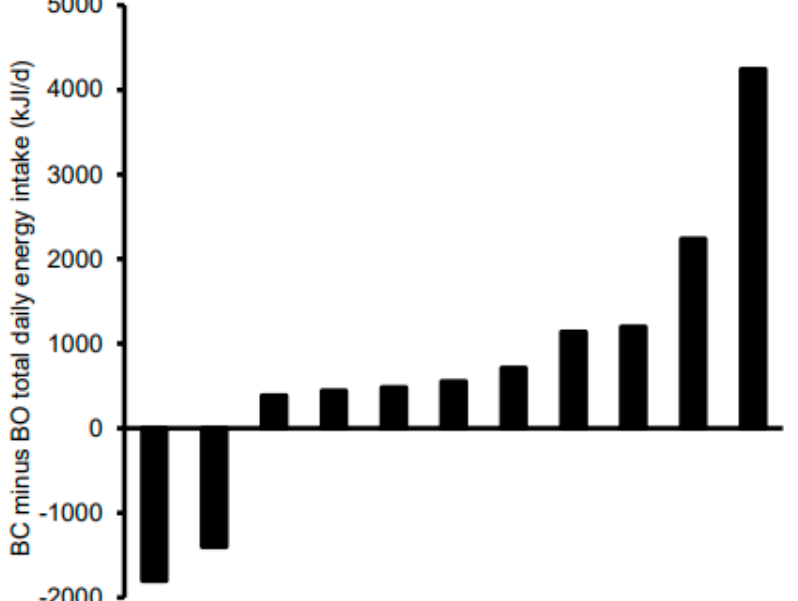
Figure 3. Individual total daily energy intakes of adolescent girls who participated in the randomised crossover trial comparing seven days of breakfast consumption (BC) with seven days of breakfast omission (BO). BC was the consumption of a standardised breakfast with an energy content equivalent to 25% of individual resting metabolic rate before 09:00 for seven consecutive days; BO was the abstinence from all energy-providing nutrients until at least 10:30 for seven consecutive